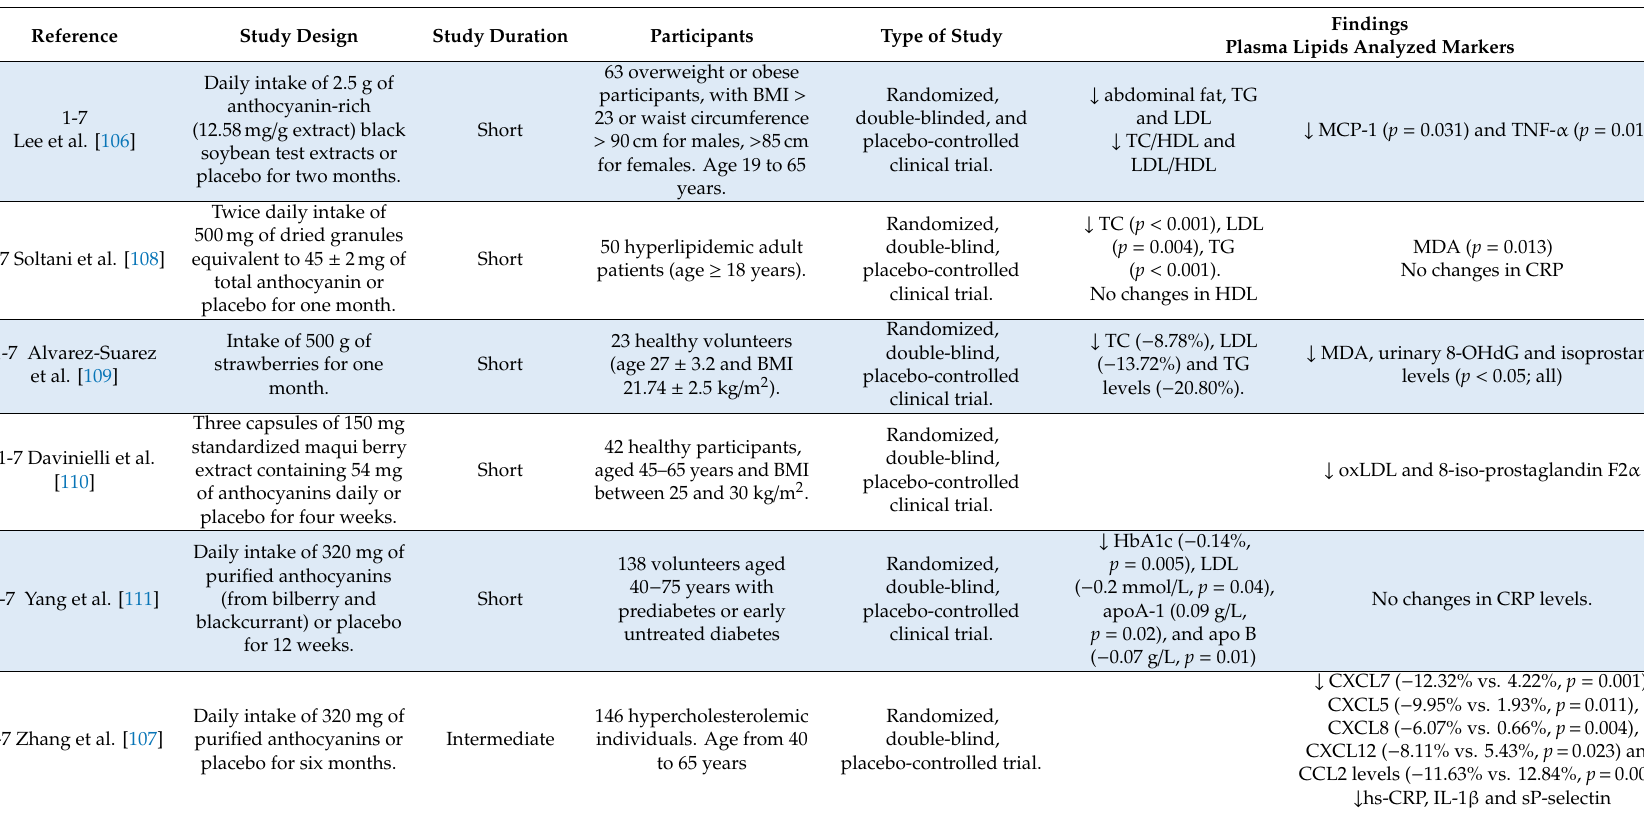
Table 3. Potential protective e ff ect of berries or their bioactive compounds on proinflammatory and oxidative stress markers during the progression of